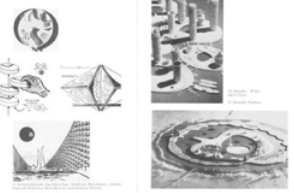
Figure 2. KiyonoriKikutake’s ocean and marina projects,